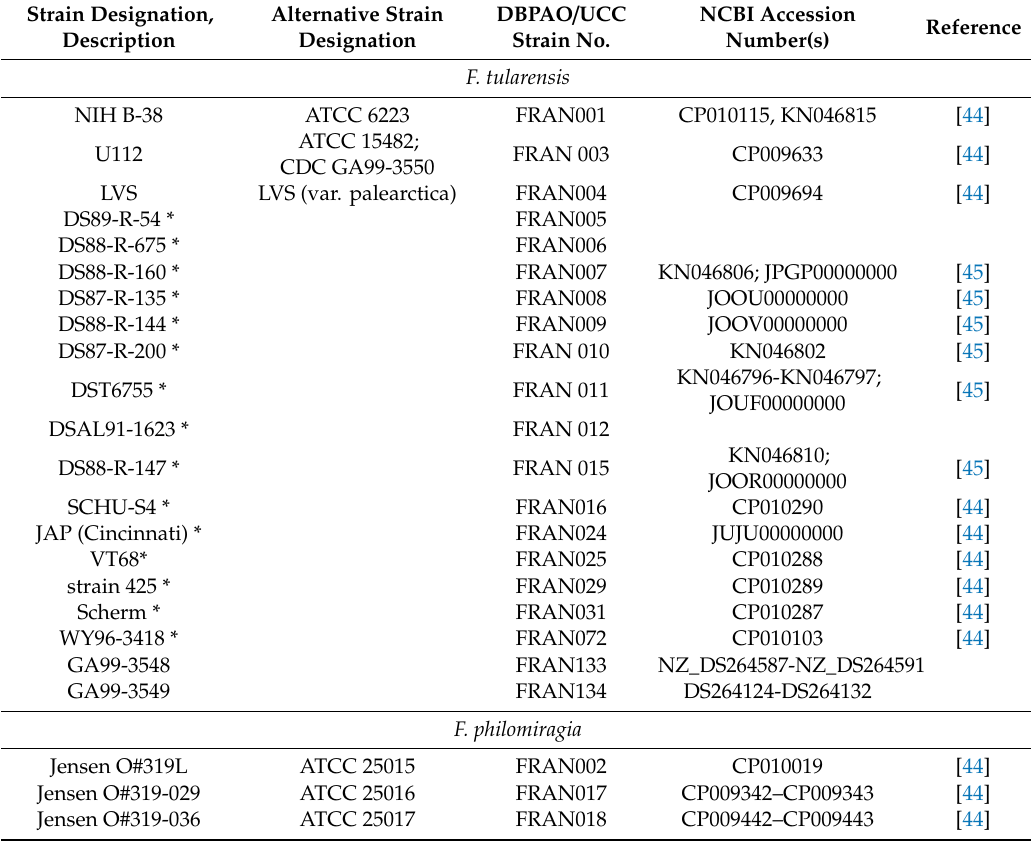
Table 9. Francisella spp. strains used in this